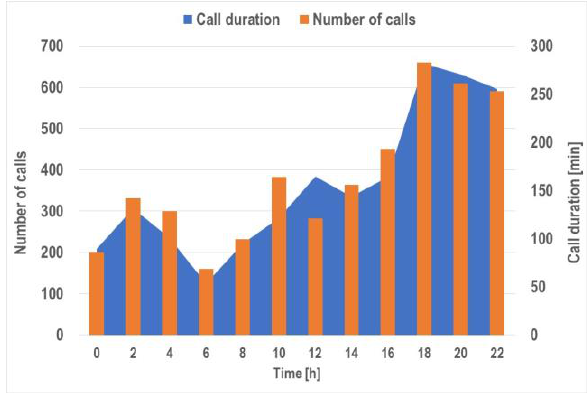
Figure 5. Overview of calls to Public Fire Department call centre